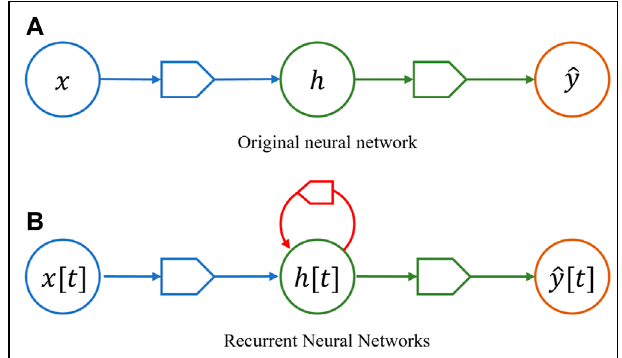
FIGURE 1 | Overview of comparison between the original networks and recurrent neural networks. (A) is the original network, and (B) represents simple architecture of the